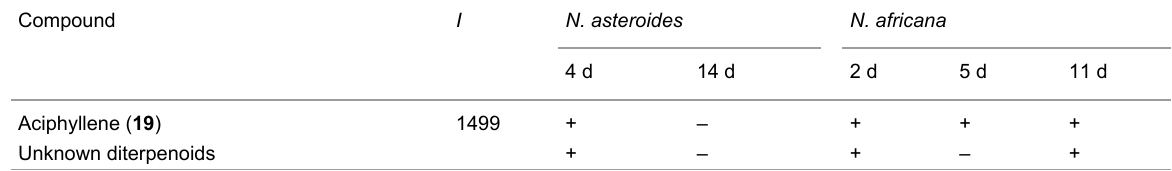
Table 6: Volatiles released by Nocardia asteroides and N. africana grown in the 7H9 broth medium. a